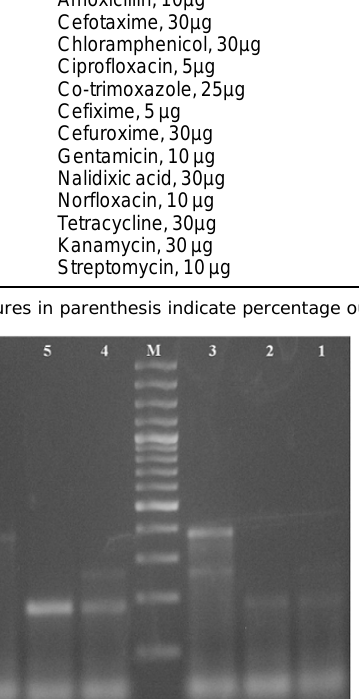
Table-2. Antibiotic sensitivity/sesistance pattern of STEC isolates (n=15) from bovines and their handlers. Sr. No.